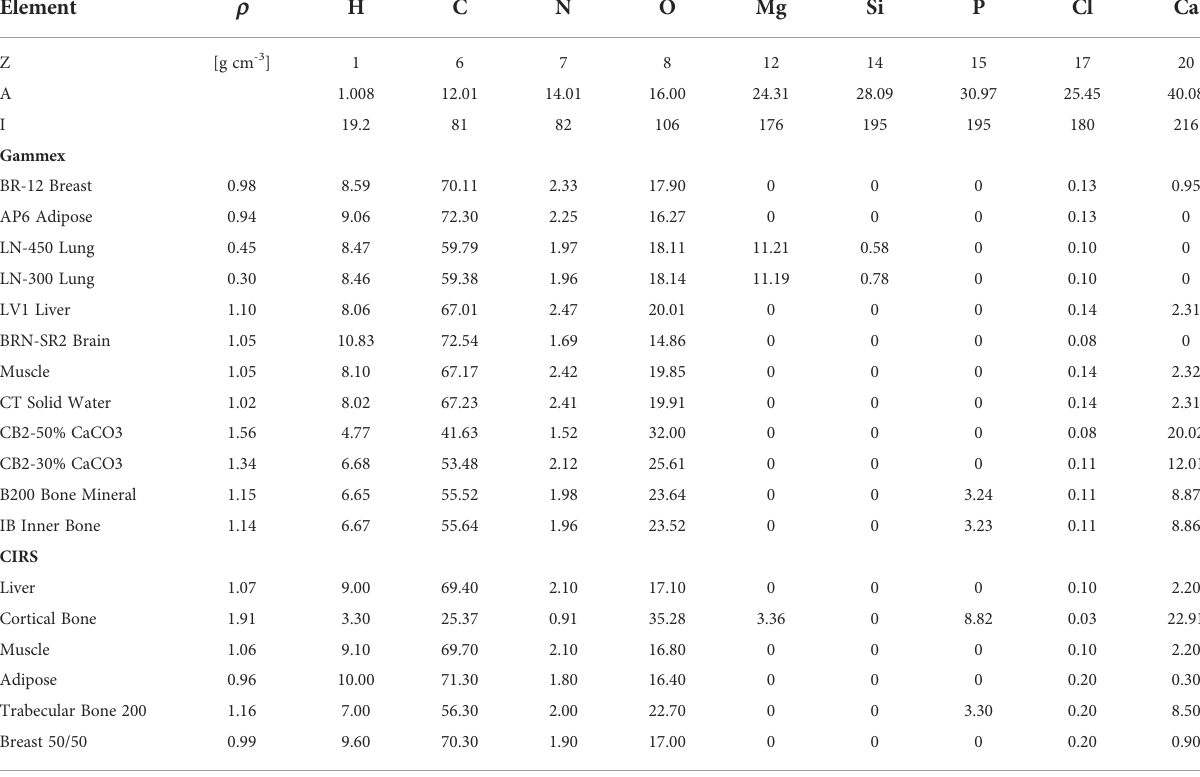
TABLE 1 Mass percent elemental composition and mass density of insert materials.